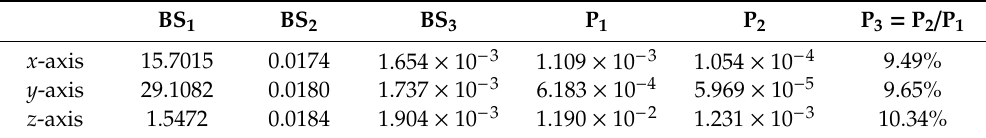
Table 5. Bias stabilities of the experimental data in 3rd experiment.